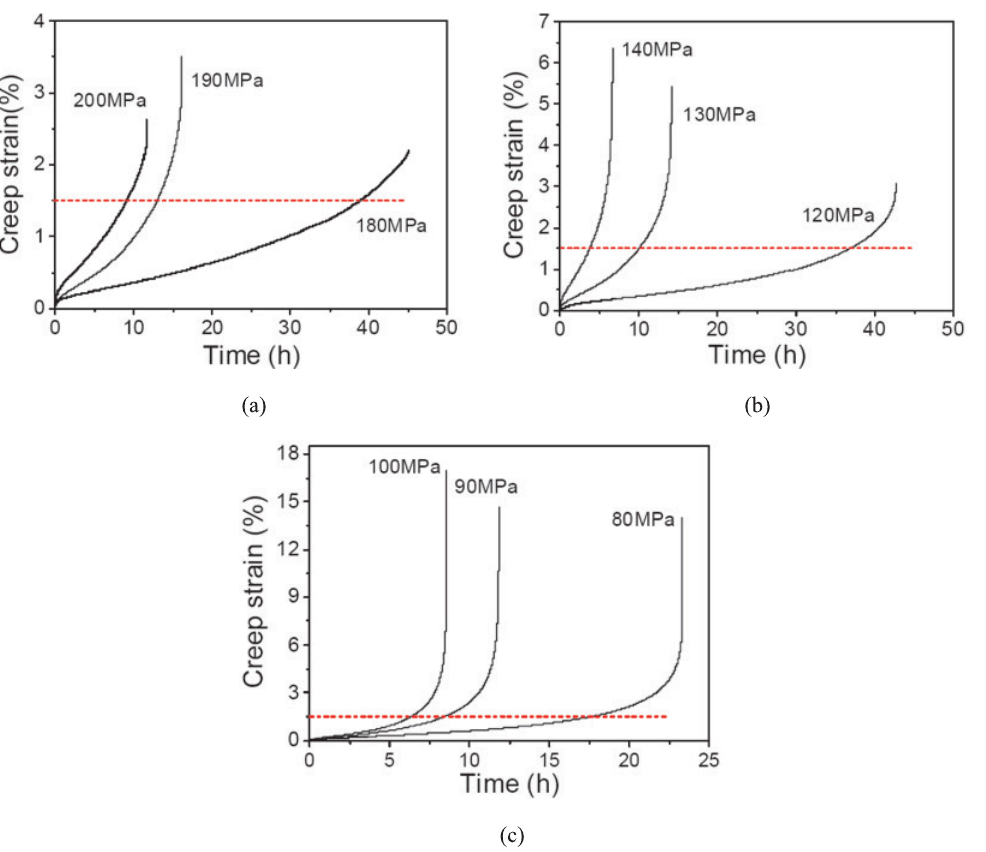
Fig. 3: Creep curves of 2124-T851 aluminum alloy obtained from constant stress uniaxial tensile creep tests at temperatures of (a) 503 K, (b) 533 K and (c) 563